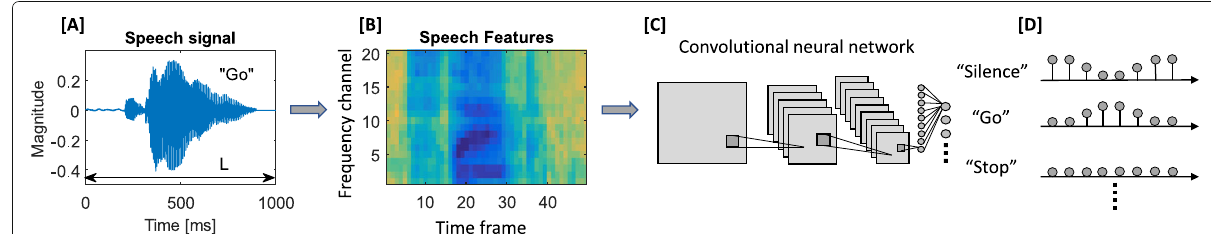
Fig. 1 Overview of the different stages in the KWS system. (A) A 1000-ms window of input signal. (B) Speech features are extracted from the input signal. (C) DS-CNN classifier generates probabilities of output classes. (D) Probabilities are combined in a posterior handling stage